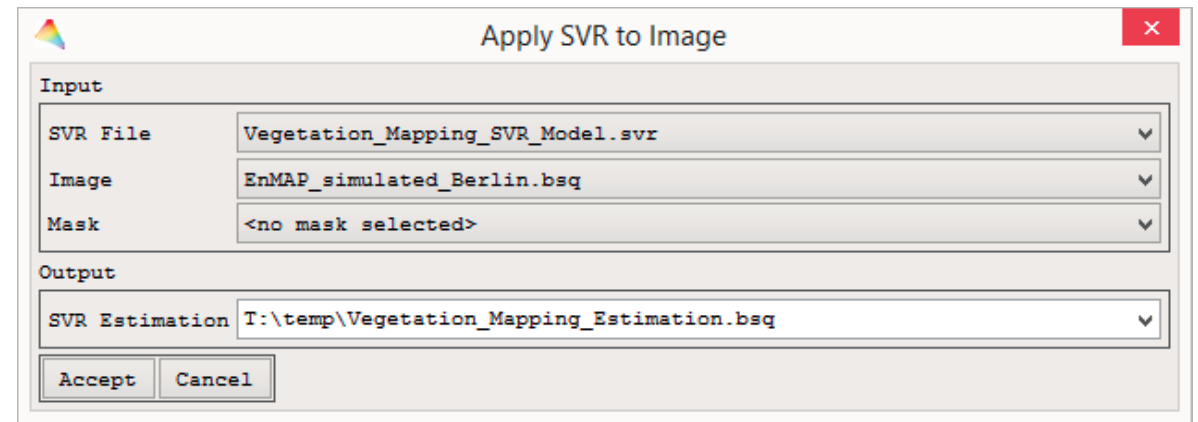
Figure 5. SVM models are separately stored and, this way, may be flexibly applied to series of images or spectral libraries.